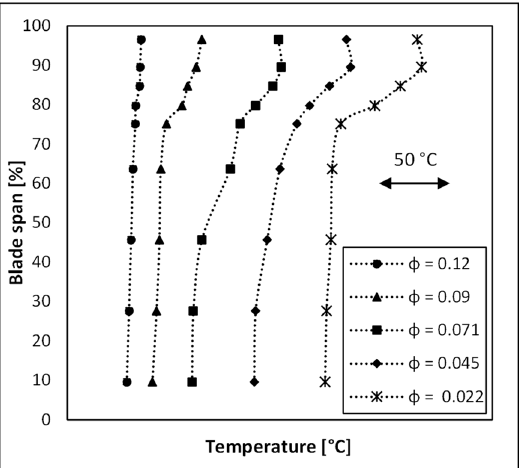
fidentiality reasons.